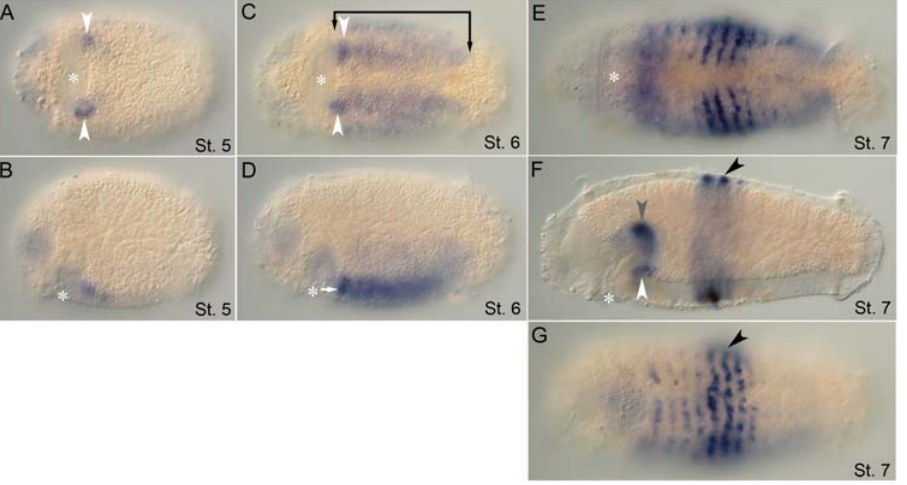
Figure 4. Expression patterns of CapI-pb during larval stages. Anterior is to the left for all panels. Stages are indicated at the bottom right of each panel. (A), (C), and (E) show ventral views; (B), (D), (F), and (G), lateral views with ventral down. Asterisk marks the position of the mouth. (A, B) CapI-pb expression in two ectodermal clusters, lateral and slightly posterior to the mouth at stage 5 (white arrowheads). (C, D) At the transition from stage 6 to stage 7, CapI-pb is expressed in the VNC (white arrow), including prominent expression in the subesophageal ganglion (white arrowheads), and ventro-lateral epidermis of all segments (bracket). (E, F) By late stage 7/early stage 8, the trunk has a segmentally iterated ectodermal stripe pattern (black arrowhead). Additional CapI-pb expression appears in the foregut (gray arrowhead), Expression persists in the subesophageal ganglion (white arrowhead). (G) Surface view showing segmentally iterated ectodermal stripes of expression, which is most prominent in T5 to T7 (black arrowhead).